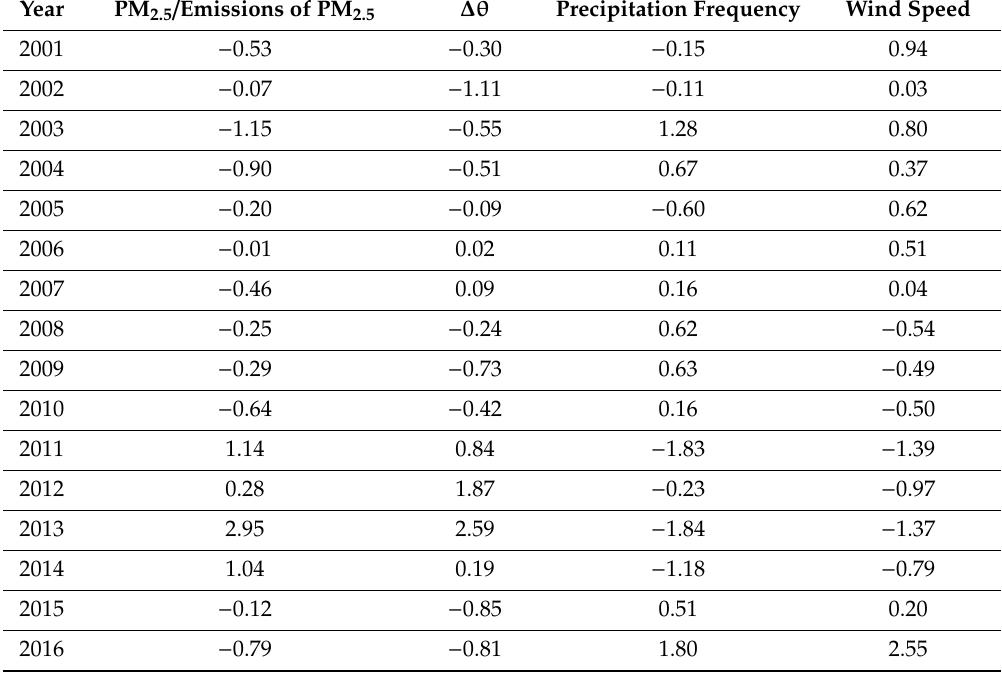
Table 8. Yearly z-scores for emissions-normalized PM 2.5 , ∆ θ , precipitation frequency and wind speed. Year PM 2.5 / Emissions of PM 2.5 ∆ θ Precipitation Frequency Wind